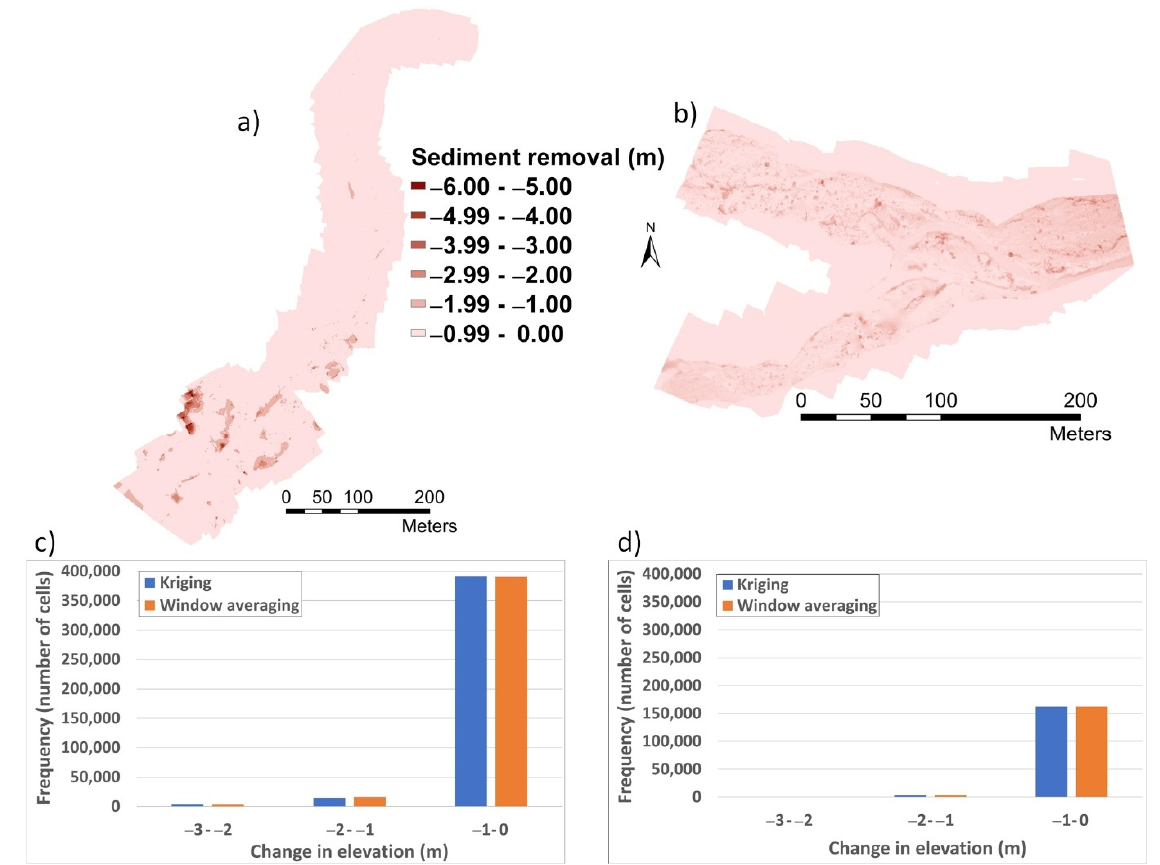
Figure 9. ( a ) Coulibistrie LiDAR-DSM-DoD filled with window averaging. ( b ) Pichelin LiDAR-DSM-DoD filled with window averaging. ( c ) Histogram comparing the cell values of Coulibistrie LiDAR-DSM-DoD filled with Kriging and window averaging. ( d ) Histogram comparing the cell values of Pichelin LiDAR-DSM-DoD filled with Kriging and window